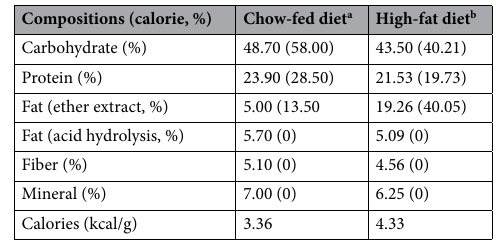
Table 2. Chow fed diet (CFD) and high fat fed diet compositions. a Laboratory Rodent Diet 5001. b The diet formula was adapted from a previous study 64